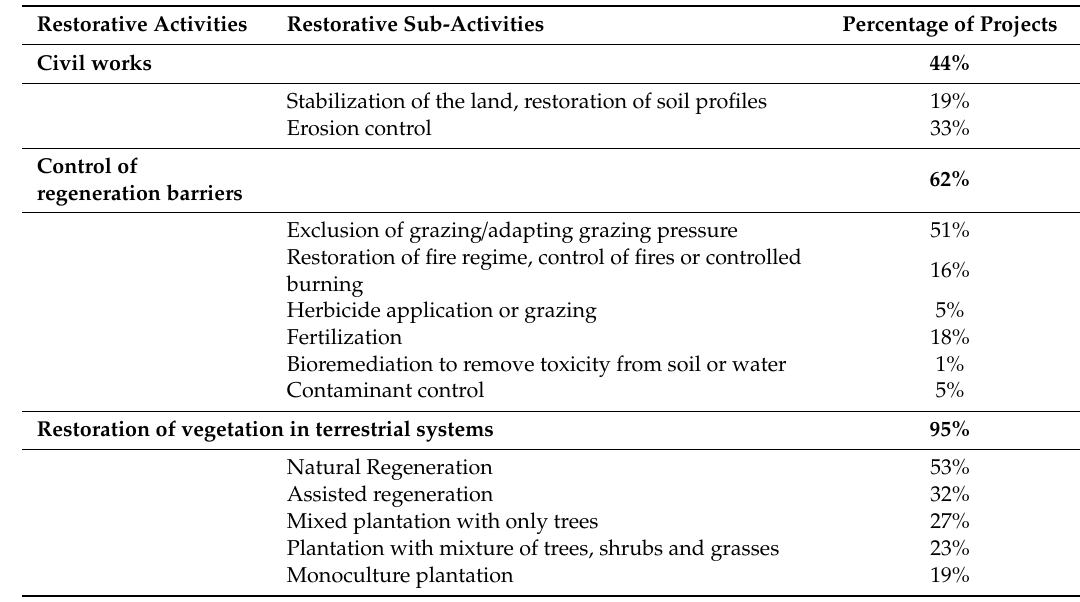
Table 4. Overview of project activities. The table shows the percentage of projects that implement a certain restorative activity and / or sub-activity. Within one project multiple activities and multiple sub-activities can take place per category. The total number of projects analysed was 154.